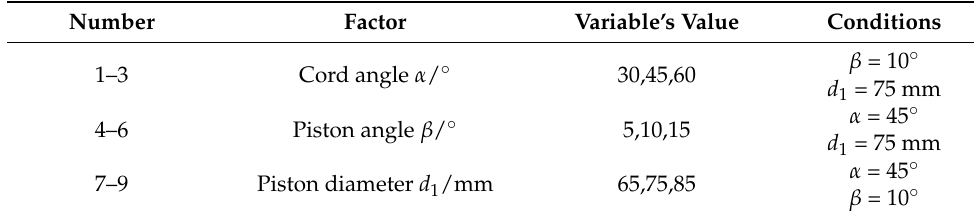
Table 2. Single-factor simulation